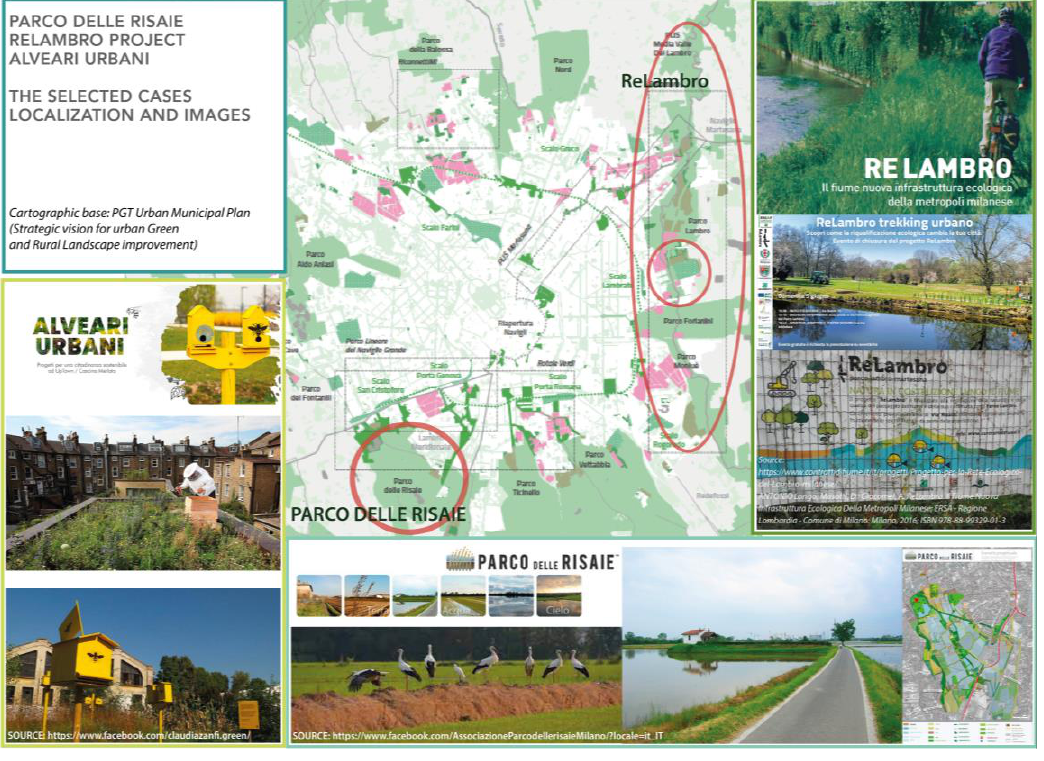
Figure 4. Localization and images from the three selected practices: Re-Lambro project, Parco delle Risaie, and some images from the Urban Beehives